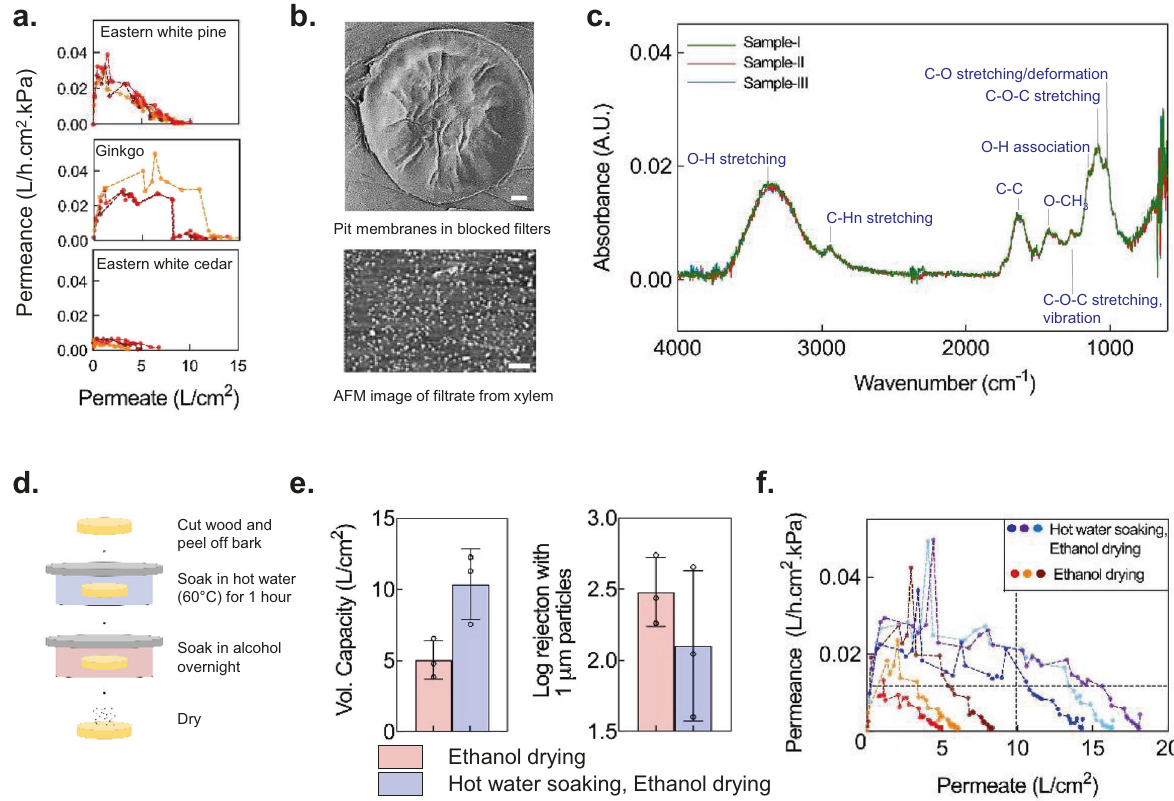
Fig. 3 Self-fouling behavior. a Permeance of 0.25-inch-thick ethanol-dried fi lters made from different gymnosperm species decreases with permeate volume when fi ltering deionized water; n = 3 different fi lters, denoted by different colors. b Micro fi brils are covered by deposited material in pit membranes of blocked fi lters (SEM image, top) and fi ltrate dried on a surface contains particulates (AFM image, bottom), suggesting dissolution and deposition of organic material within the fi lter. Scale bars, 2 μ m. c FTIR spectra of different samples of fi ltered water indicate that hemicellulose leaches out of xylem fi lters. Modes corresponding to FTIR peaks are speci fi ed. A.U. stands for Absorbance Unit. d – f Hot-water soaking improves volumetric capacity (vol. capacity) and retains rejection (0.375-inch-thick fi lters). Mean ± s.d. are indicated in ( e ); n = 3 different fi lters. Different colors denote different fi lters in ( f )). Data were obtained with 1-cm diameter Eastern white pine fi lters operated under 1-m gravity head. The horizontal dashed line denotes the permeance (0.01 L/h.cm 2 .kPa) corresponding to the target fl ow rate of 1 L/h with a 10-cm 2 fi lter area and 1-m gravity head, whereas the vertical dashed